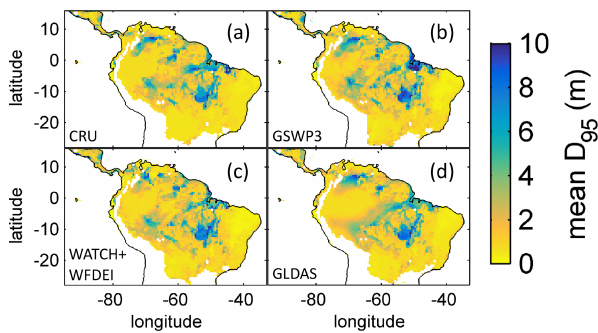
Figure 2. Regional NPP-weighted mean rooting depth ( D 95 ) of all sub-PFTs (evergreen and deciduous PFTs combined) for 2001–2010 and different climate inputs simulated with LPJmL4.0- VR. (a) CRU climate input. (b) GSWP3 climate input. (c) WATCH + WFDEI climate input. (d) GLDAS climate input. The colour-scale maximum is set to 10m.